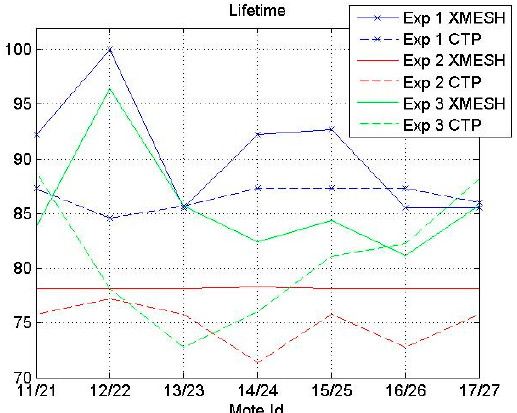
Figure 4. Percentage of the relative lifetime of each mote using the XMESH and CTP protocols.